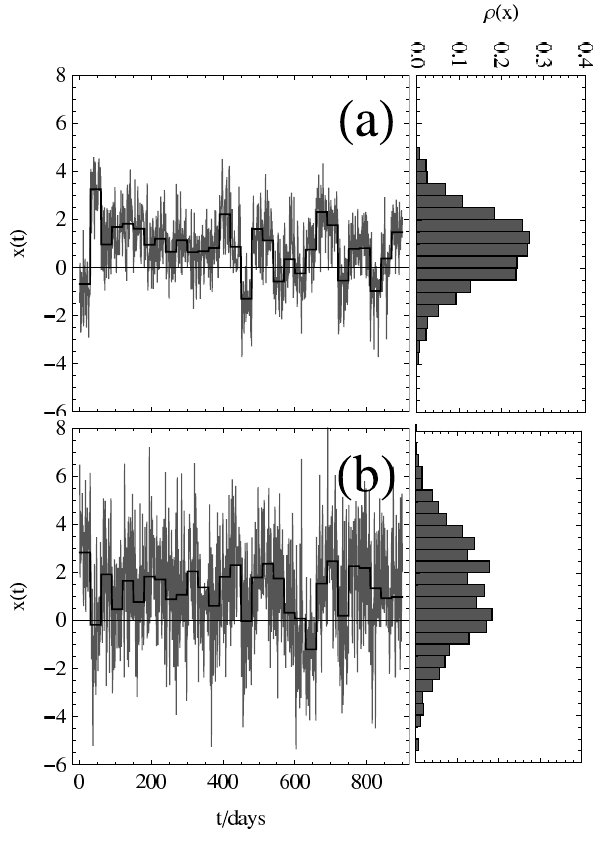
Fig. 2. Example of modeled ( a , gray) and observed ( b , gray) time series of daily data, monthly means indicated by heavy black lines; Panels on the right are normalized histograms of the daily time series.